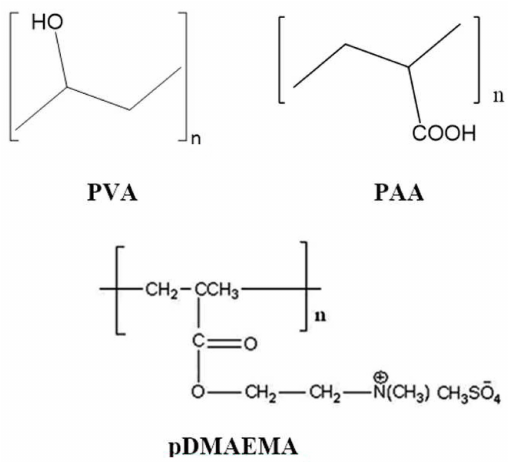
Figure 1. Chemical structures of the studied